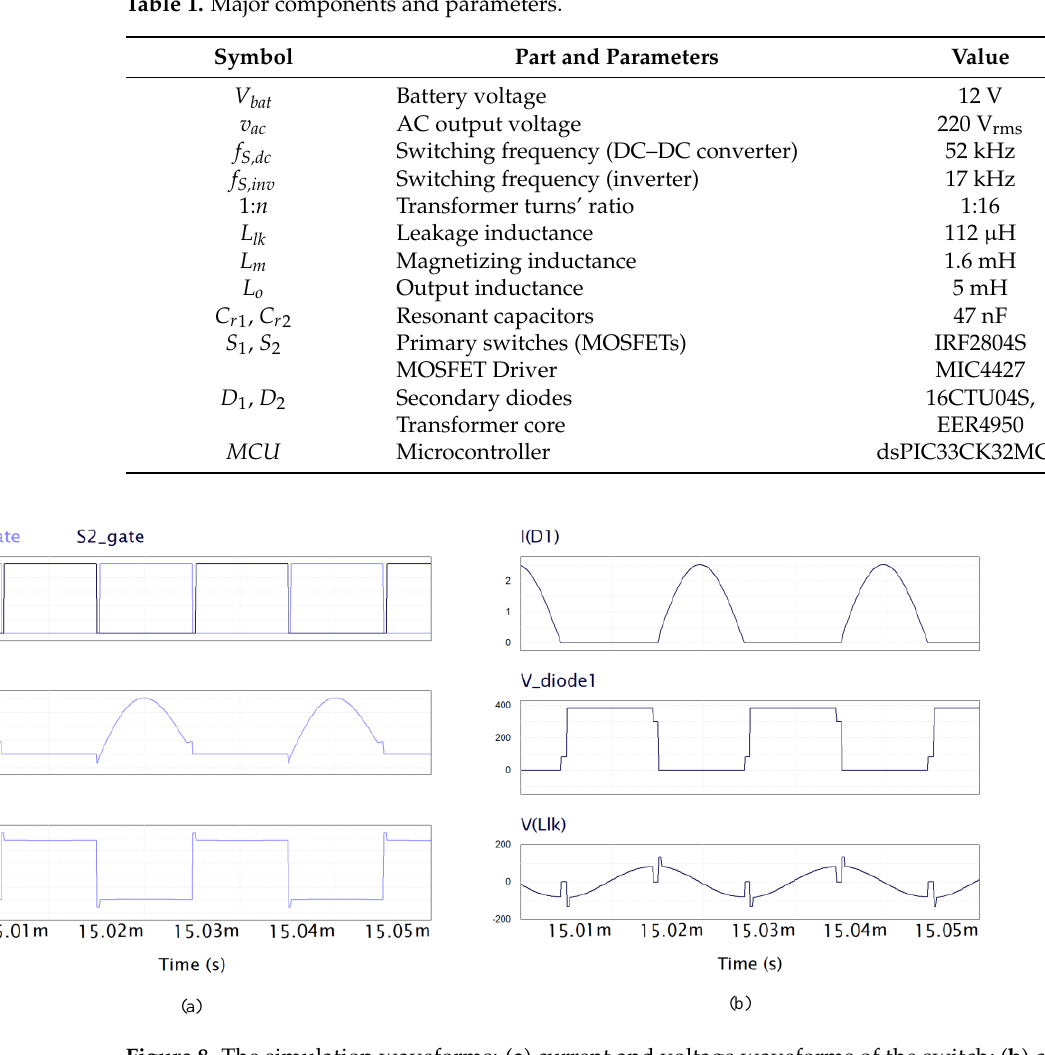
Figure 8. The simulation waveforms: ( a ) current and voltage waveforms of the switch; ( b ) current and voltage waveforms of the diode.